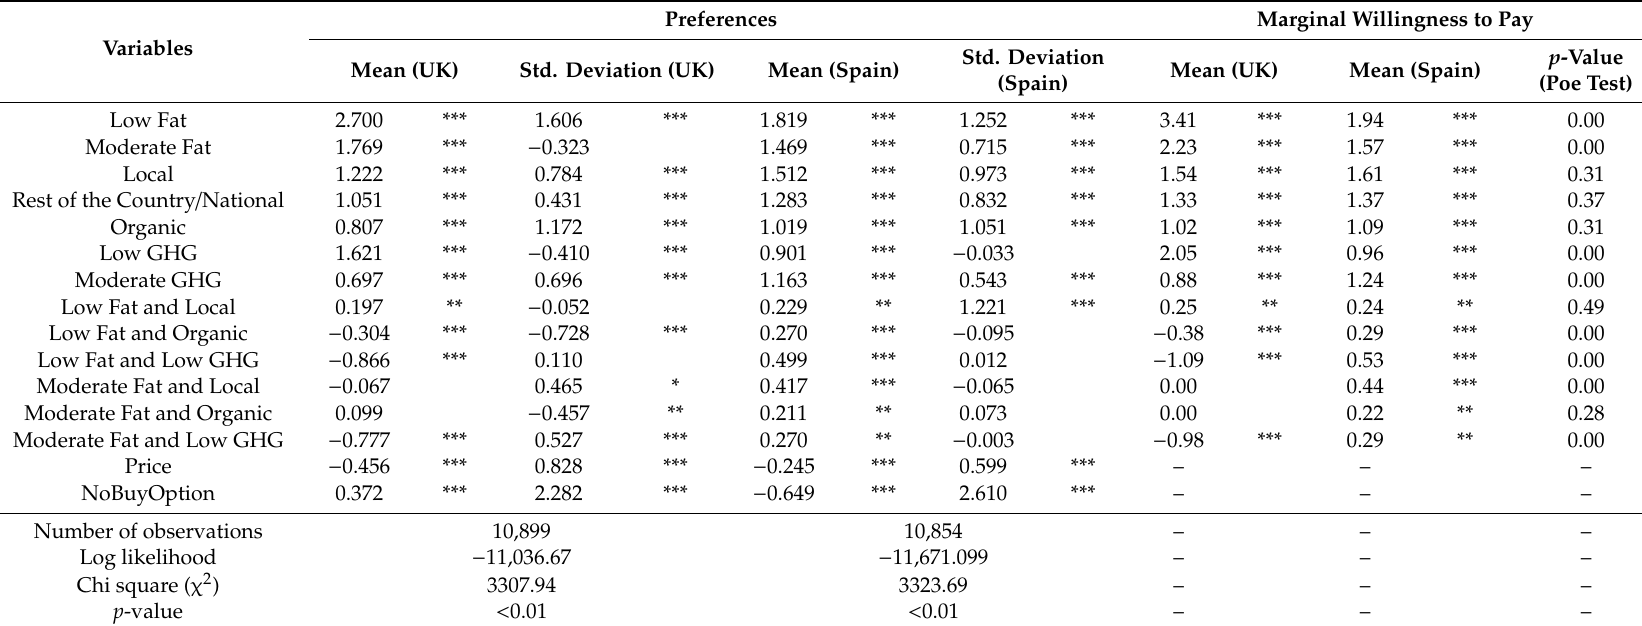
Table 3. Estimated marginal utilities and willingness to